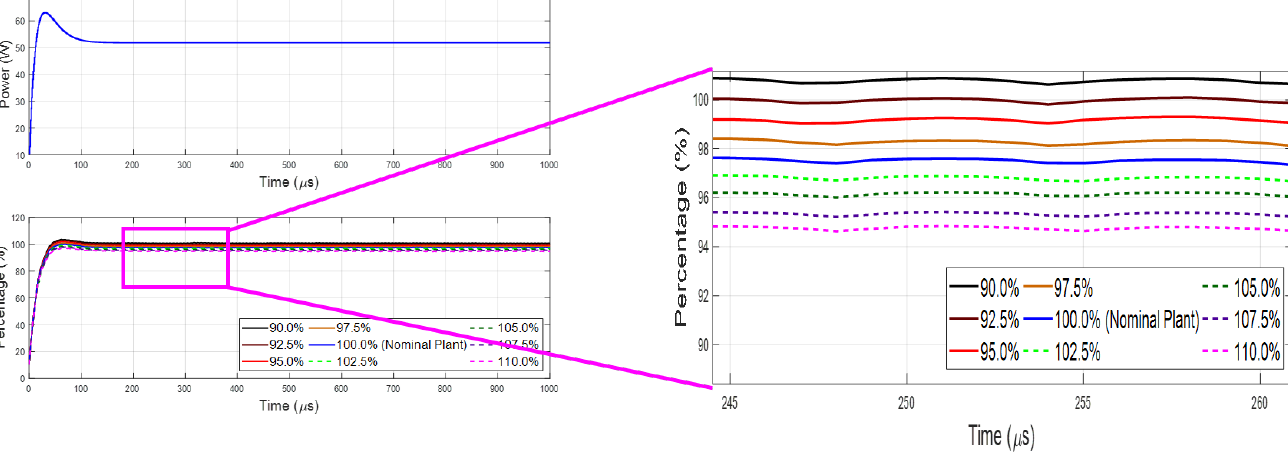
Figure 14. Robustness in continuous (CW) and pulsed (PW) laser.